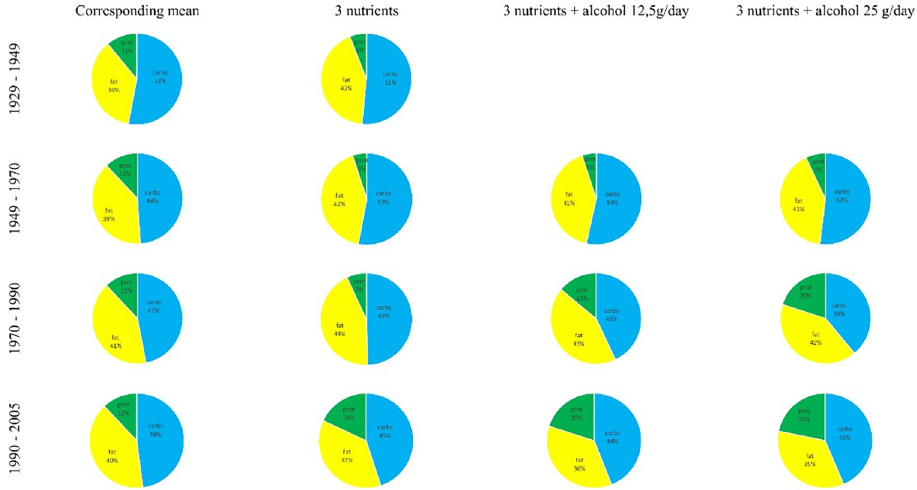
Fig 5. Wheel charts of the recalculated proportions of macronutrients in percent of the energy units for each period studied.